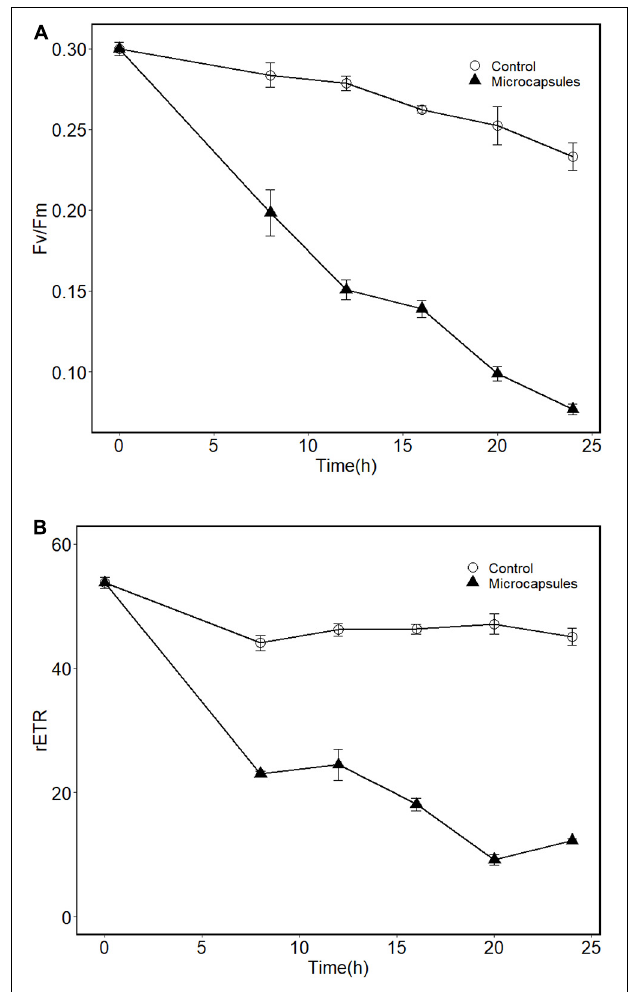
FIGURE 5 | Effects of floating microcapsules on the fluorescence Fv/Fm (A) and rETR (B) of A. sanguinea. Controls are microcapsules without algicidal powder. Values are means ± s.e, n =